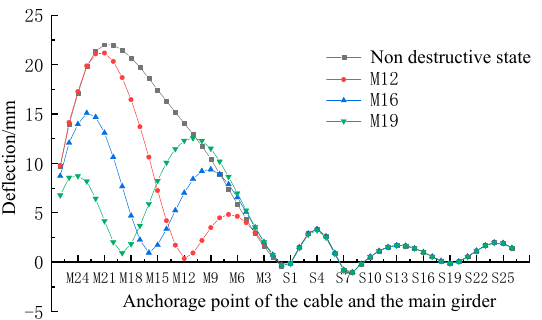
Figure 15. The deflection distribution curve of the girder in nondestructive state and after the cable damaged (50%) When the overall temperature dropped 15 °C.